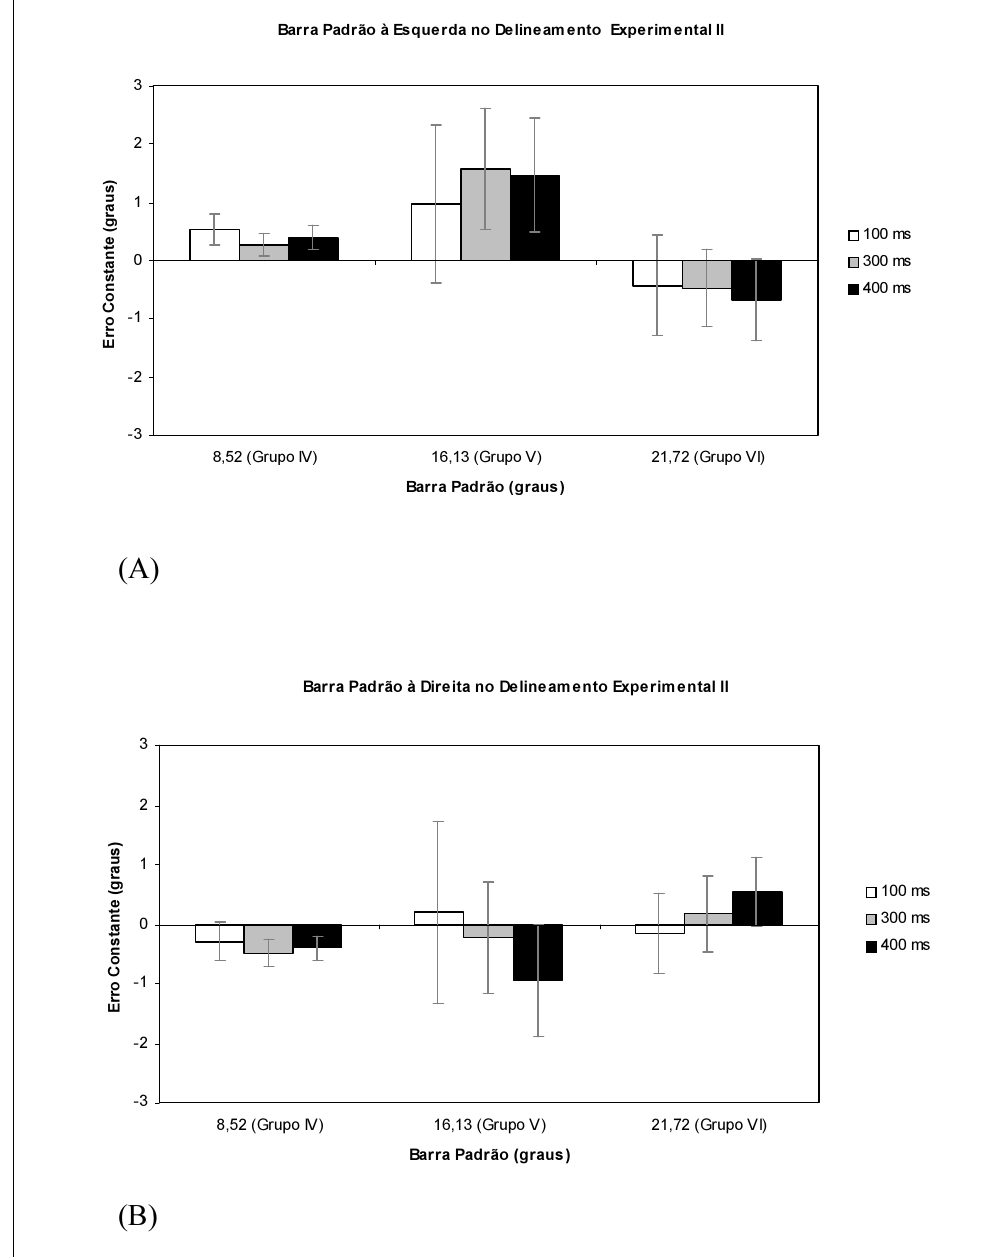
Figura 3 . Médias dos erros constantes dos três tamanhos da barra padrão, nos três tempos de exposição dos estímulos, com os respectivos erros padrão do Delineamento Experimental II Nota . (A) Condição em que a barra padrão foi apresentada à esquerda do ponto de fixação. (B) Condição